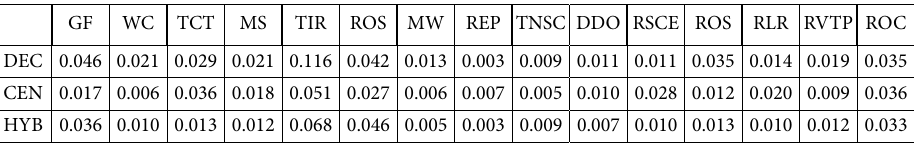
Table 11. Normalized the D matrix